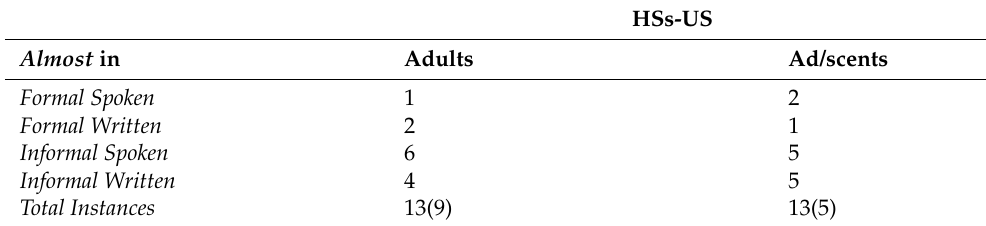
Table 5. Distribution of fast per settings and modalities in Germany-HSs. Fast in Adults Ad/scents Formal Spoken Formal Written Informal